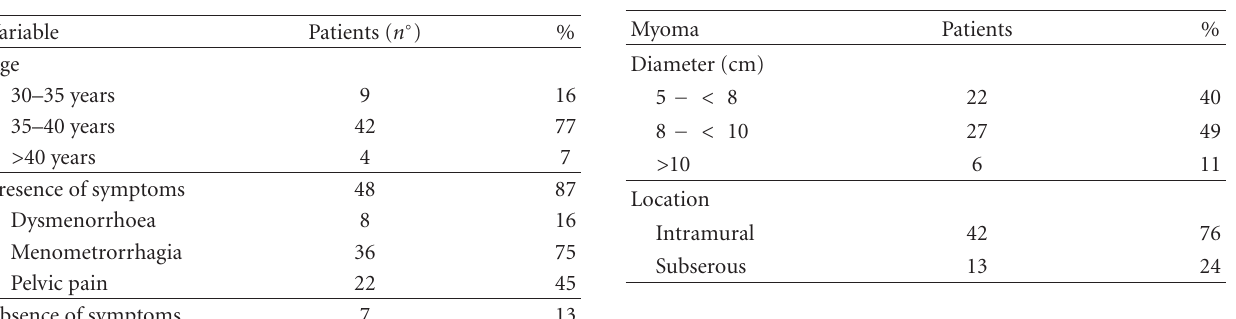
Table 1: Distribution of patients according to age, dysmenorrhoea, menometrorrhagia and pelvic pain at previous surgery.